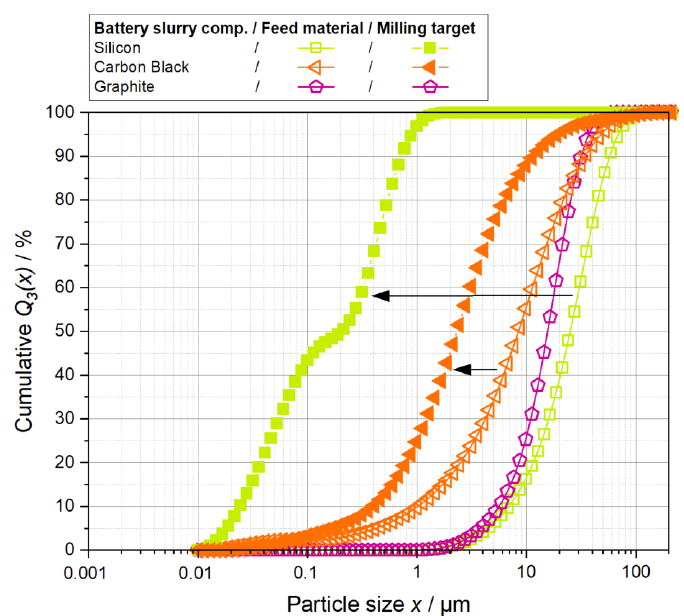
Figure 10. Particle size sum distributions Q 3 ( x ) of the three particulate feeds silicon, carbon black, and graphite and their milling targets for the production of silicon-containing anodes (gained by the reference process).